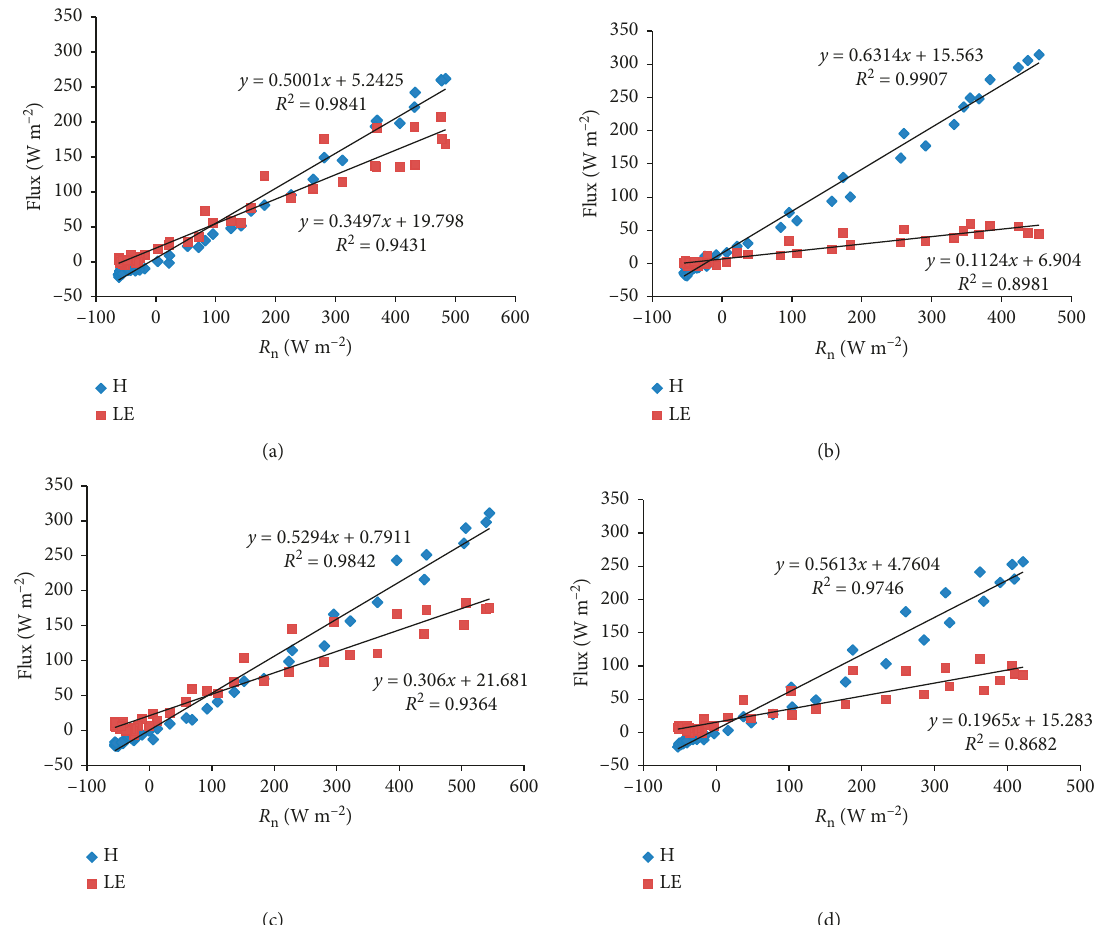
Figure 3: Scatter plots of H and LE as a function of R and R n are in (W m − 2 ·